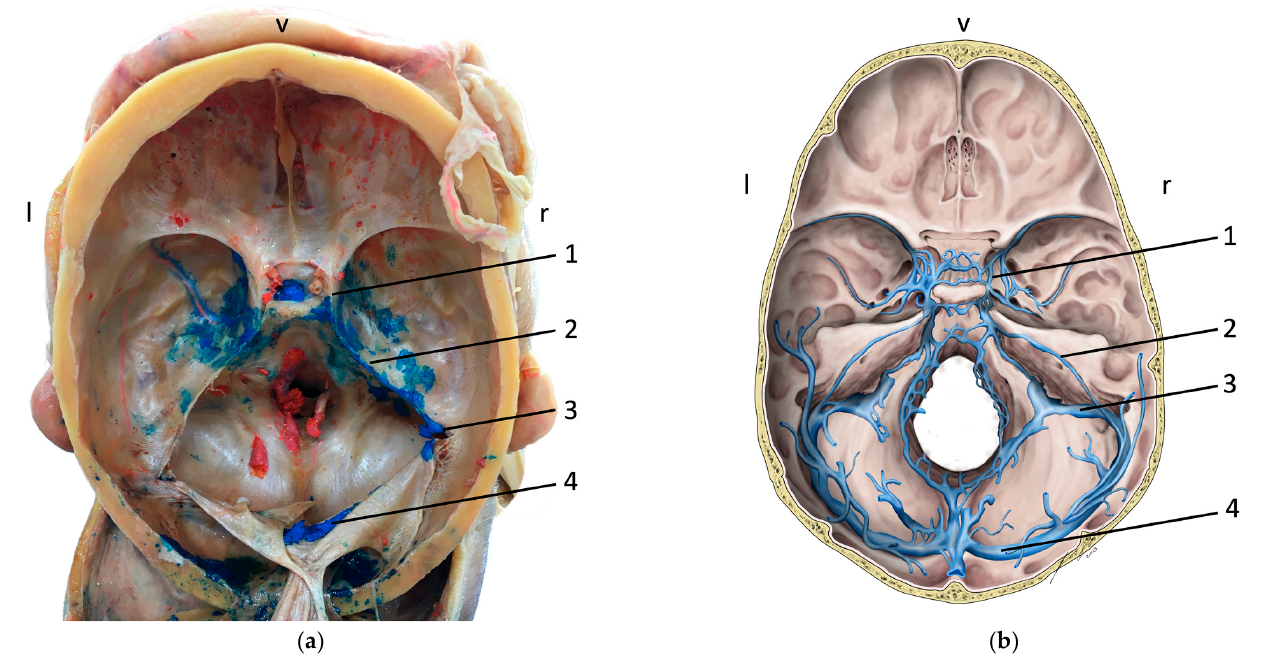
the anastomoses between the facial vein and the superior ophthalmic vein as well as the intracranial dural sinuses. cs—cavernous sinus, and iov—inferior ophthalmic vein.